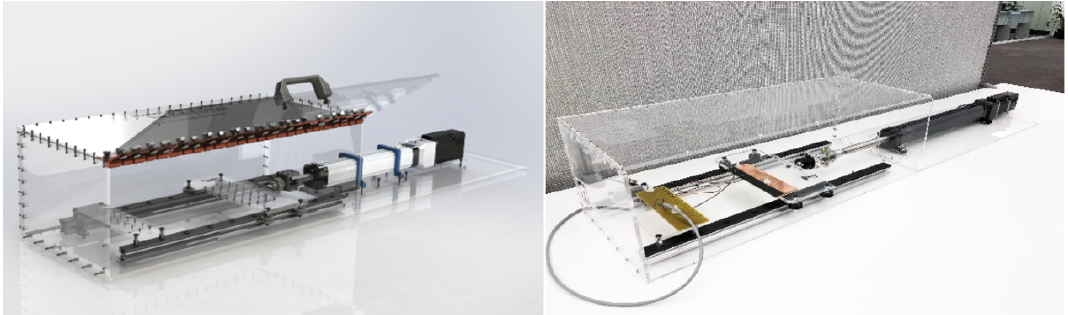
Figure 3. Left: A 3D visualization of the fully assembled rig made on SolidWorks 2018 software; Right: The real assembled rig made in “Maker-Space”, Western Sydney University, Penrith,